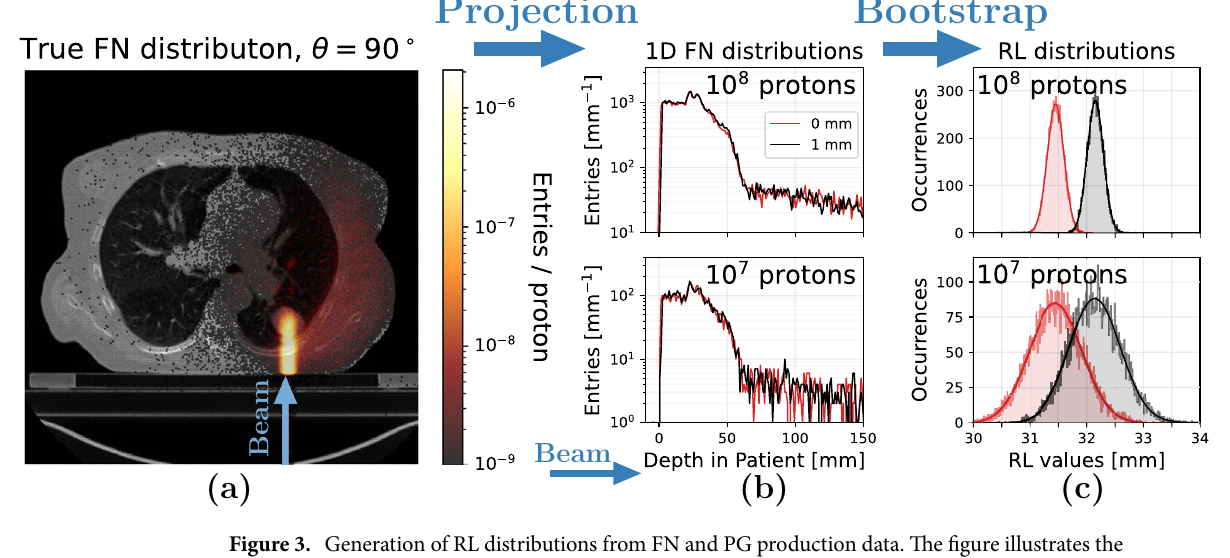
Figure 3. Generation of RL distributions from FN and PG production data. The figure illustrates the procedures utilized to obtain RL distributions. First, the true FN points of origin in the patient, ( a ), are mapped onto a 1D histogram along the incident proton beam direction. Examples of such histograms are shown in ( b ) for true proton beam range shifts of 0 mm and 1 mm at proton intensities of 10 distributions, individual RLs are calculated. Then, sub-sampling bootstrapping is used to obtain a distribution of RLs at varying proton intensities. Example RL distributions are shown in ( c ) for proton intensities of 10 10 7 . The distributions get wider at lower proton intensities with a resulting increase in overlapping portions. Although the example illustrates the use of FN data, the procedure is the same for PG data. Note also that the procedure is similar for reconstructed FN and PG distributions with the difference being the mapping of reconstructed FN and PG production distributions in 2D onto a 1D